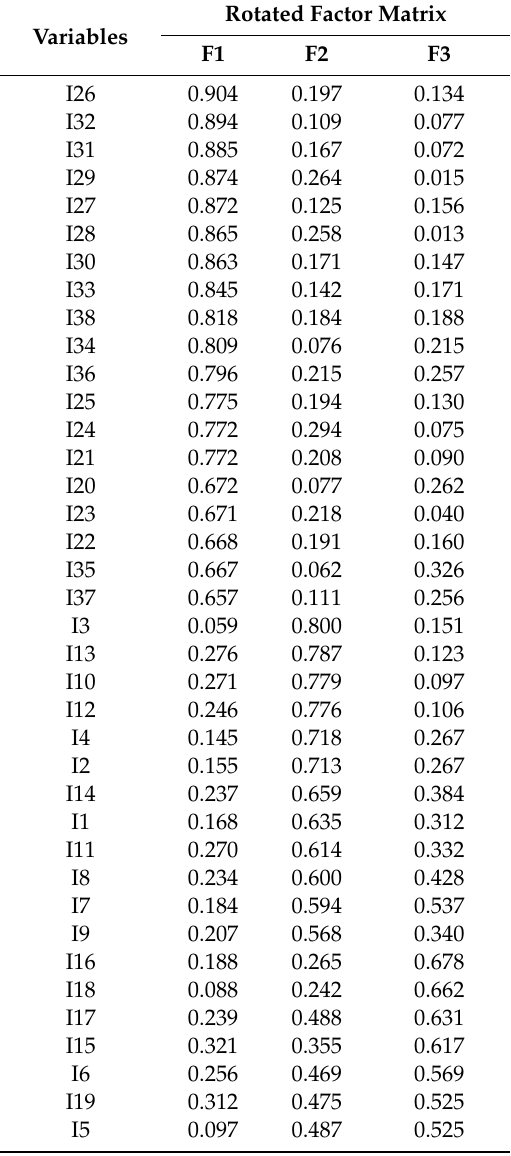
Table 3. Rotated Factor